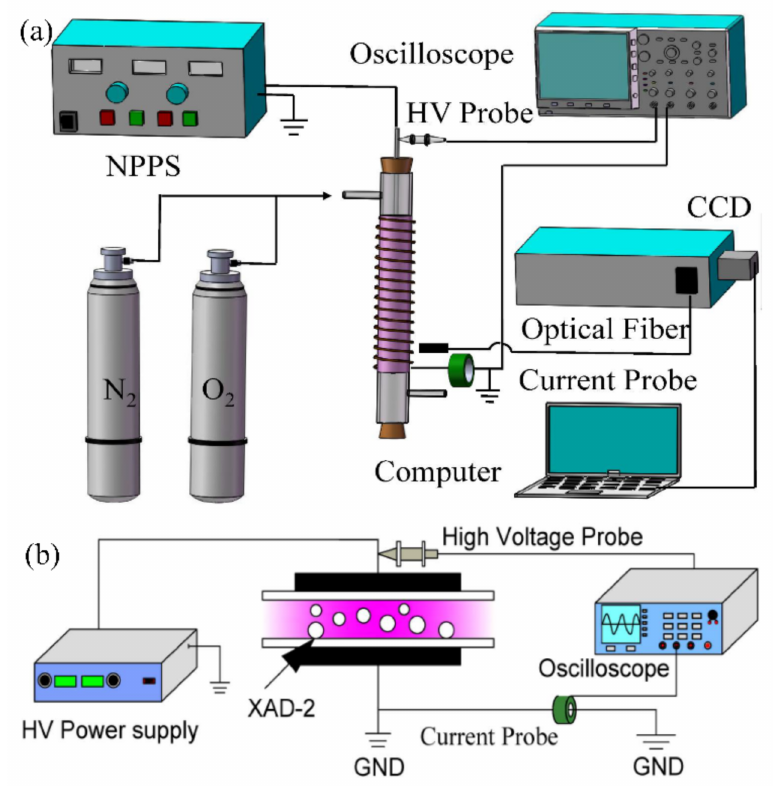
Figure 5. A schematic diagram of the experimental setup of ( a ) line–tube DBD plasma treatment reactor and ( b ) plate–plate DBD plasma treatment reactor [85,86].